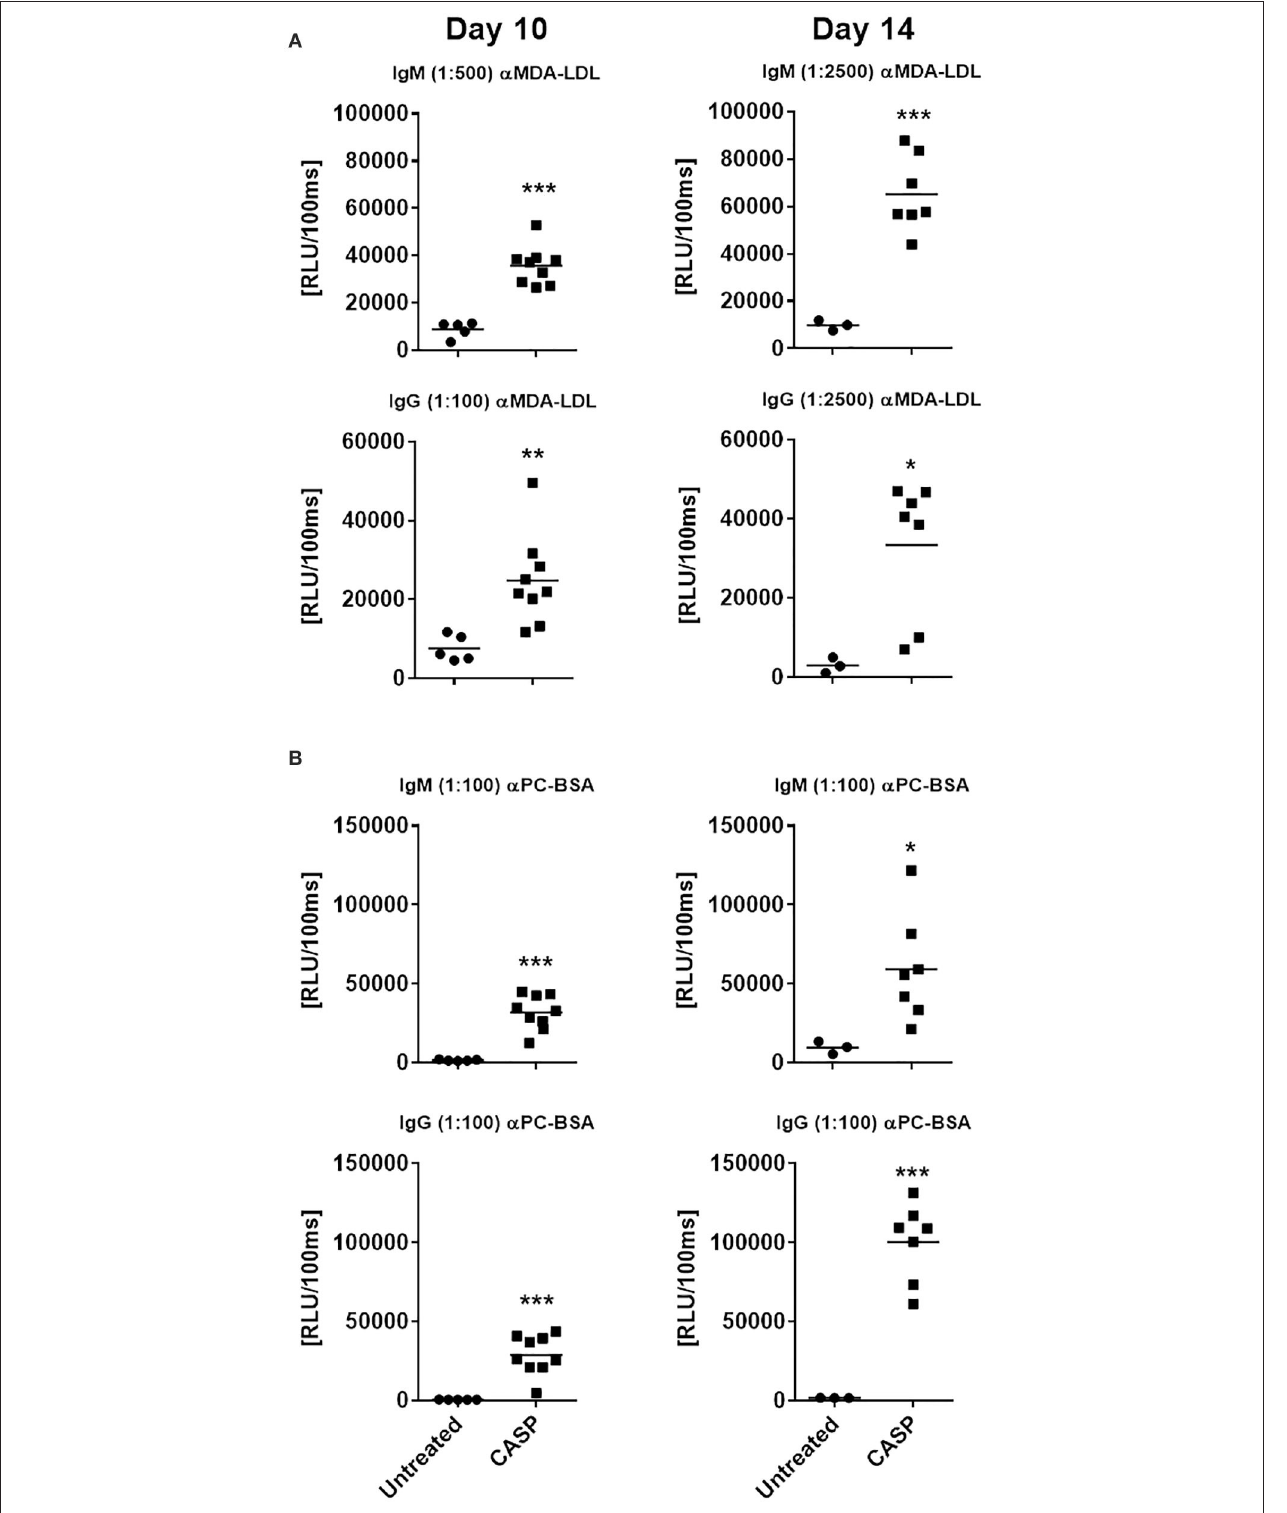
FIGURE 3 | Serum IgM and IgG binding to model oxidation-specific epitopes. C57BL/6 mice were subjected to CASP surgery, while control animals remained untreated. Ten and 14 days after sepsis induction, blood was drawn to determine serum IgM and IgG binding to malondialdehyde-modified LDL [MDA-LDL; (A) ] and phosphocholine-conjugated BSA [PC-BSA; (B) ], using chemiluminescent ELISA. Serum dilutions used are indicated in brackets. Statistical analysis was performed using the unpaired t -test. N = 3–9 per group. * p < 0.05, ** p < 0.01, *** p < 0.001.